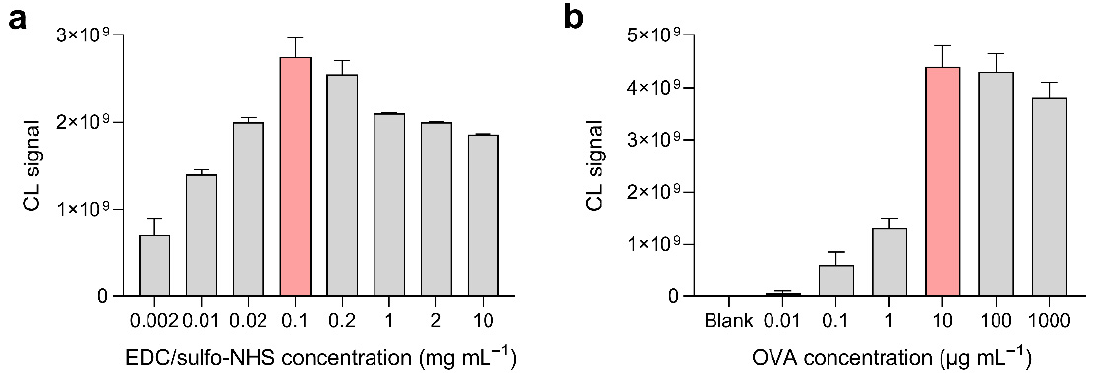
Figure 3. ( a ) CL signals obtained by employing different EDC/sulfo-NHS concentrations for the activation of the surface carboxyl groups of the MBs. Activated carboxyl groups were quantified by reaction with an excess of HRP, followed by CL detection of the bound enzyme. ( b ) CL signals obtained by employing different OVA concentrations in the coating of activated MBs to obtain OVA- MBs. Ovalbumin bound to MBs was quantified by reaction with an excess of anti-OVA-HRP, followed by CL detection of the conjugate. The optimal experimental conditions are highlighted in red. Each of the data are the mean ± SD of three